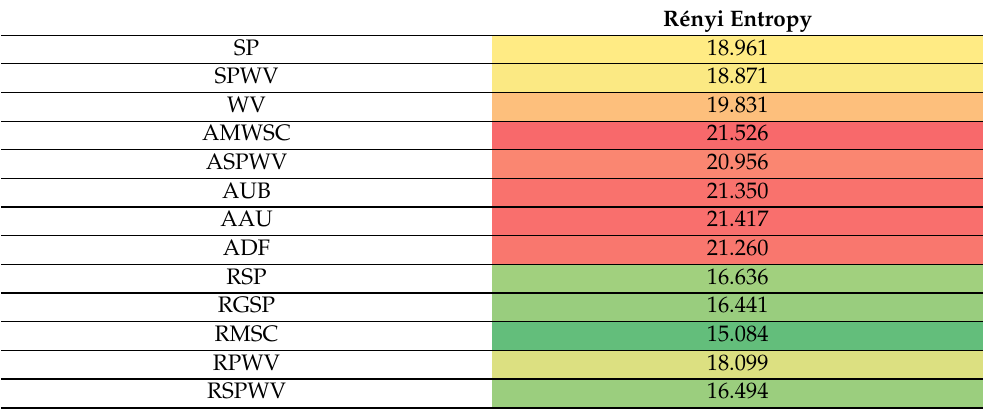
Table 10. Rényi entropy for the 2020 Zagreb earthquake vertical acceleration seismogram, cell colors range from green for the best result to red for the worst result in each column